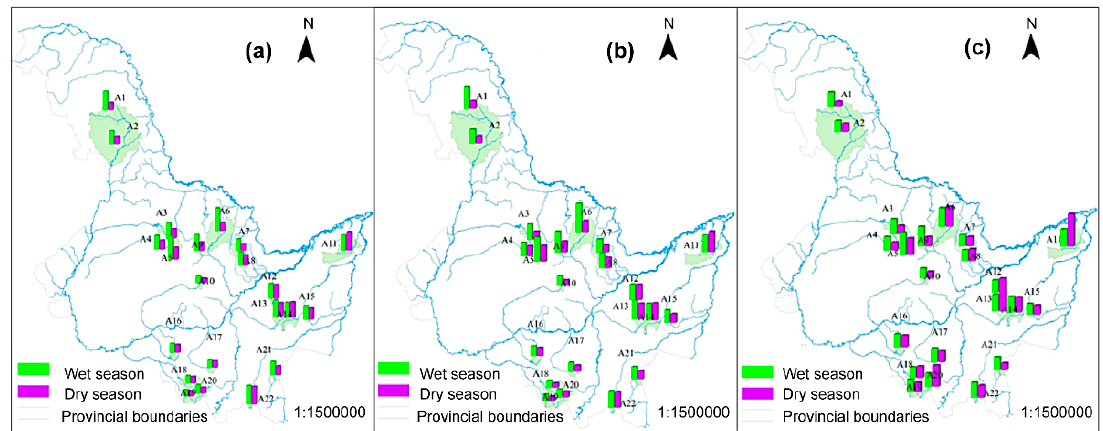
Figure 4. Spatiotemporal change of failed variables between dry and wet seasons. ( a ) COD; ( b ) COD Mn ; and ( c ) NH 3 -N.